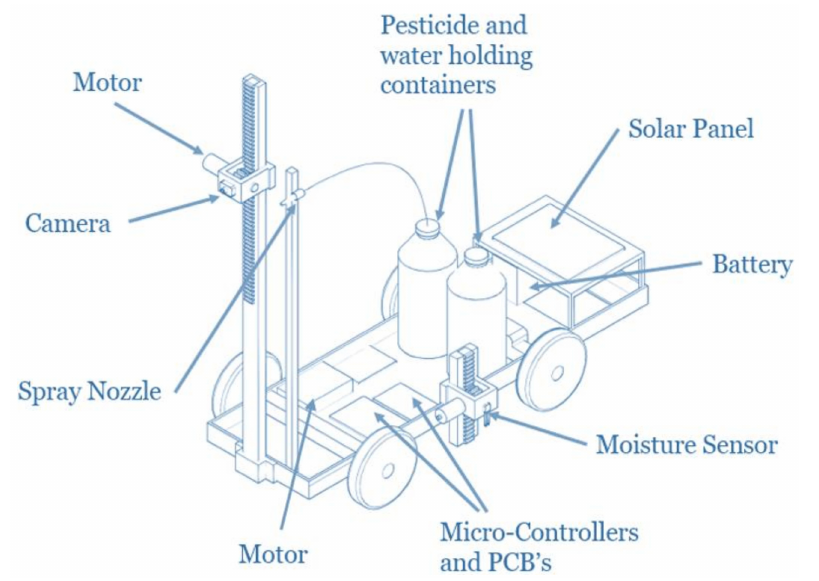
Figure 2. The layout of the Multi-Purpose Robot for Smart Farming (Note: PCB-Printed Cir- cuit